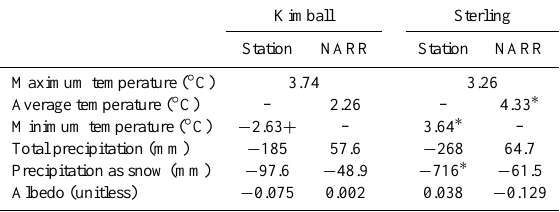
Table 1. Comparison of the trends per century from 1981 to 2010 for station and North American Regional Reanalysis (NARR) data sets at Kimball and Sterling. The trend with a plus sign indicates a significant trend at the p < 0.10 level and an asterisk indicates significance at the p < 0.05